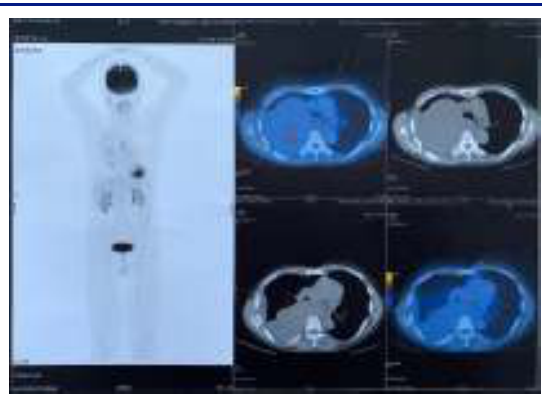
Figure 2 : F18-fluorodeoxyglucose positron emission tomography (FDG-PET) showed FDG uptake with a maximum standardized uptake value of 4,